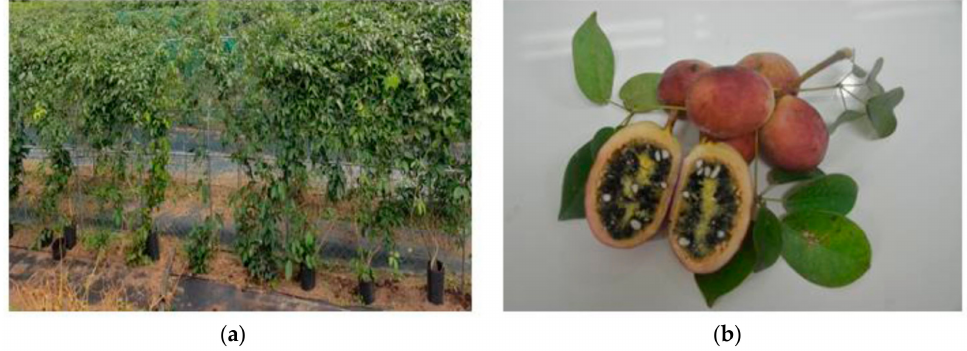
Figure 1. Photographs of Stauntonia hexaphylla fruit; ( a ) Cultivated fields ( b )